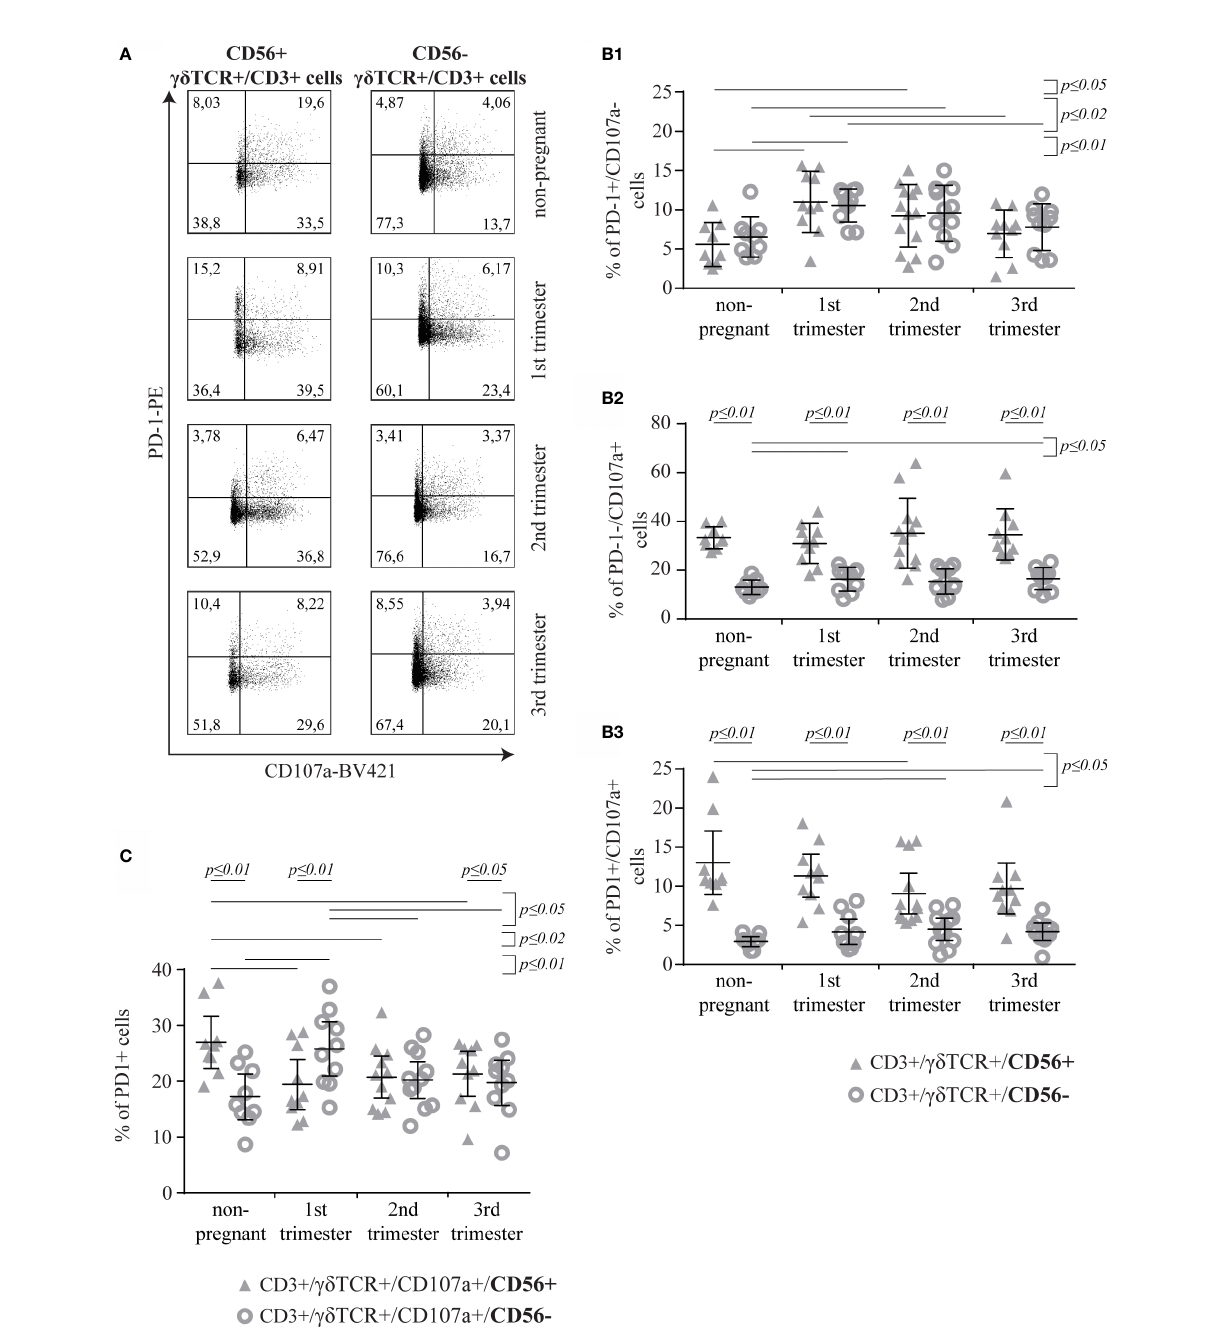
FIGURE 5 | Representative PD-1/CD107a dot plots of peripheral blood CD56+ or CD56 − gd T cells (CD3+/ gd TCR+) in non-pregnant and pregnant (1 st , 2 nd , and 3 rd trimester) women (A) . Rates of PD-1+/CD107a − (B1) , PD-1 − /CD107a+ (B2) and PD-1+/CD107a+ (B3) cells among peripheral blood CD56+ or CD56 − gd T cells (CD3+/ gd TCR+) in non-pregnant (n = 9) and pregnant [1 st (n = 10), 2 nd (n = 10), and 3 rd (n = 13) trimester] women (B) . Percentage of PD-1+ cells among CD107a+ cells in the peripheral blood CD56+ or CD56 − gd T cells (CD3+/ gd TCR+) in non-pregnant (n = 9) and pregnant [1 st (n = 10), 2 nd (n = 10), and 3 rd (n = 13) trimester] women (C) . The means of the data presented in Panels B and C are depicted as a horizontal line with the 95% con fi dence interval represented by whiskers. The individual data points are shown as triangles (CD3+/ gd TCR+/CD56+ or CD3+/ gd TCR+/CD107a+/CD56+, respectively) or circles (CD3+/ gd TCR+/CD56 − or CD3+/ gd TCR+/CD107a+/CD56 − , respectively). Statistical analysis was performed by using the paired-samples-t-test to compare data between the CD56+ and CD56 − gd T cell population and the unpaired-samples-t-test to compare within the same population but at different timepoints. Signi fi cant differences are depicted by a horizontal line above the respective data